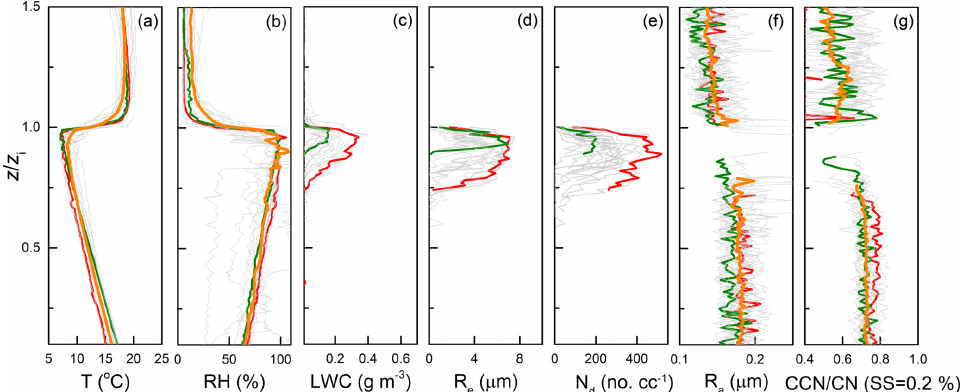
Figure 2. Vertical profiles scaled by the inversion height; (a) temperature (K), (b) relative humidity (%), (c) liquid water content (gm − 3 ), (d) cloud droplet effective radius (µm), (e) cloud droplet number concentration (cm − 3 ), (f) aerosol effective radius (µm), and ( g ) the number concentration ratio of CCN to aerosols for all 16 non-drizzling flights. The gray lines show all individual flights, and the orange lines indicate the average profiles. The red and green lines represent the polluted (18 October) and clean (9 November) cases, respectively.